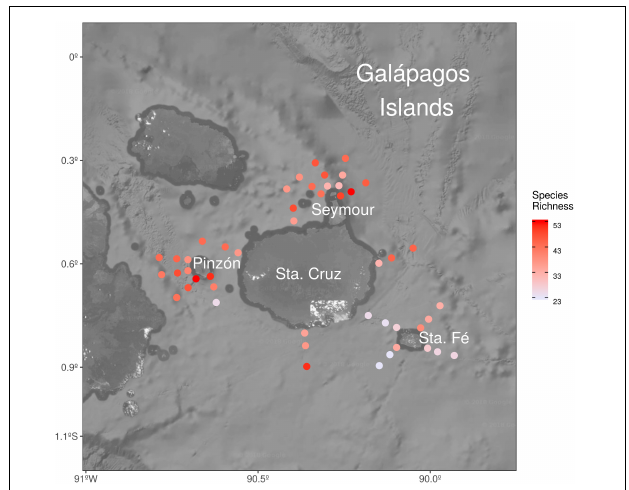
FIGURE 2 | Spatial (horizontal) distribution of the species richness in the area of